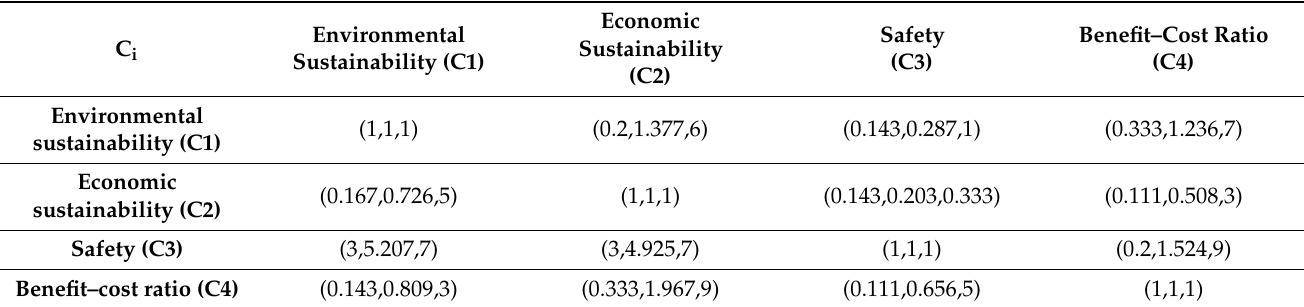
Figure 1. The values of decision-makers’ pairwise comparison matrix based on TFNs are indicated in Table 2. Table 2. The results of the expert survey.